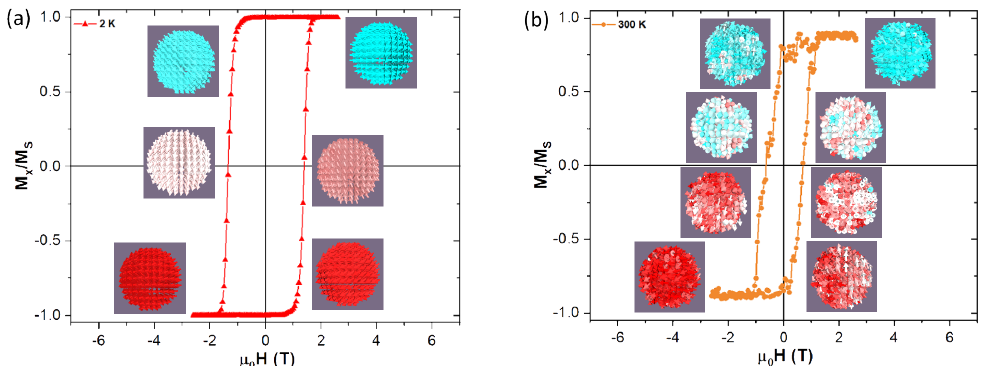
Figure 6. ( a ) Magnetization isotherm reversal for the 0.5 nm shell at 2 K, with corresponding insets showing the spin structure during the transition process. ( b ) Magnetic isotherm reversal for the 0.5 nm shell at 300 K, with corresponding insets showing the spin structure during the transition process. One can easily see on the insets how the individual spins become quite “disorganized” at higher